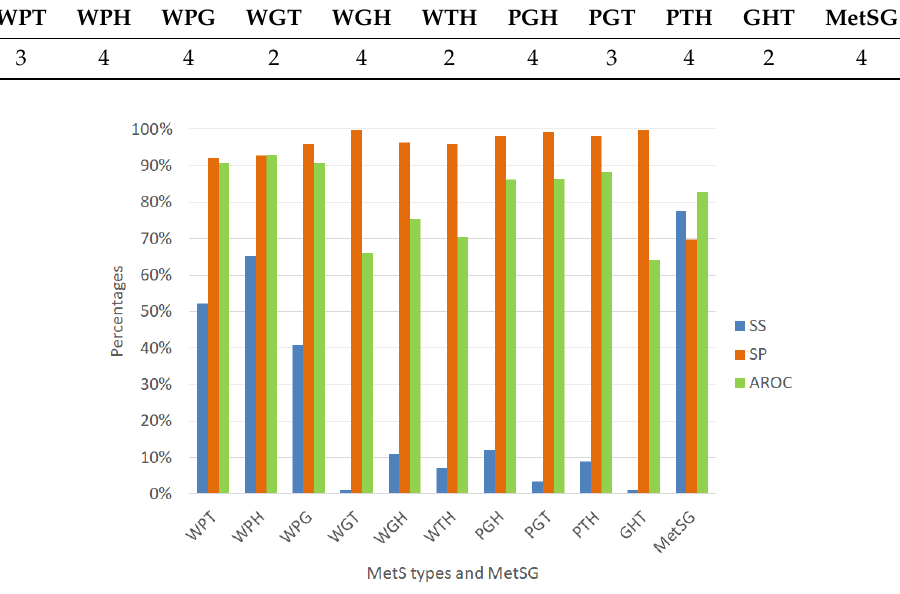
Figure 11. Performance indicators of the ANN for the MetS types using the dataset with